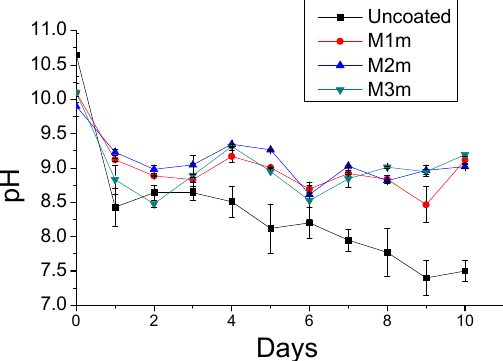
Figure 9. Surface pH values of coated (by methyl-cellulose coatings) and of uncoated concrete specimens, sprayed daily with 17% of the respective reaction’s stoichiometry (using thick layers), during the first 10 days of acid spraying. The data points and the error bars denote the mean and the standard deviation, respectively.